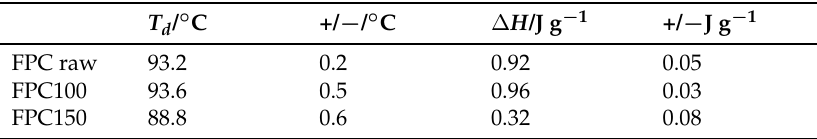
Figure 8. Thermograms of 0.15 gg − 1 dispersions of dry-heated and non-dry-heated FPC as well as commercial SPC, produced with Differential Scanning Calorimetry (DSC). A ramp of 5 ◦ Cmin − 1 was used and each sample was measured in two cycles. The second cycles did not show any peaks for any sample. Table 1. Average peak temperature and enthalpy of protein denaturation of dry-heated and non-dry-heated FPC. n = 3. Values obtained using the TA Instruments software TRIOS. Dry-heating at 150 ◦ C shifted the peak to a lower temperature and reduced the enthalpy to a third of the value of non-dry-heated